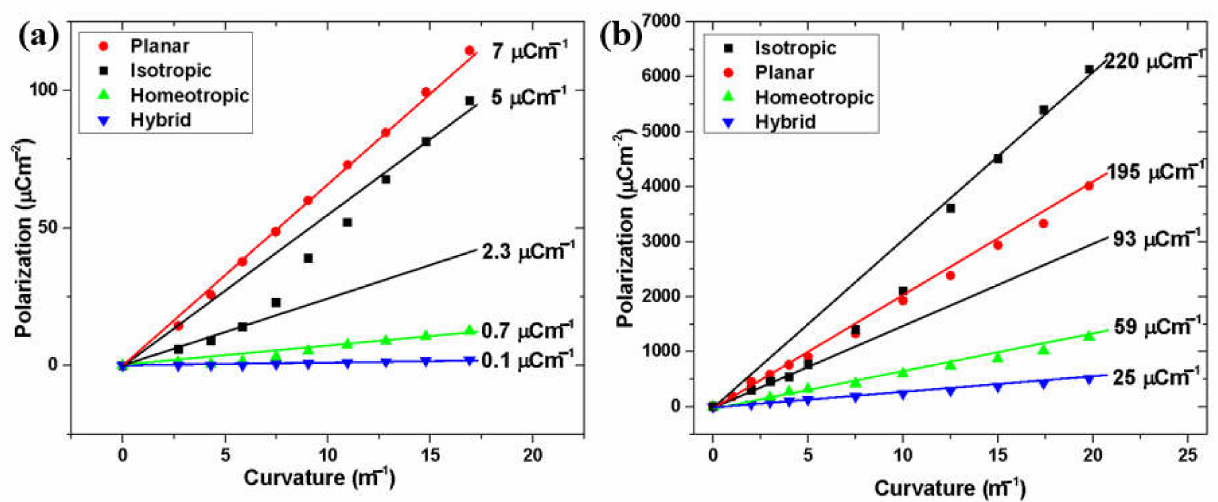
Figure 3. Flexo-ionic polarization versus bending curvature of differently aligned iLCE samples. ( a ) 1 Hz sine wave bending ( b ) 10 mHz square wave mechanical